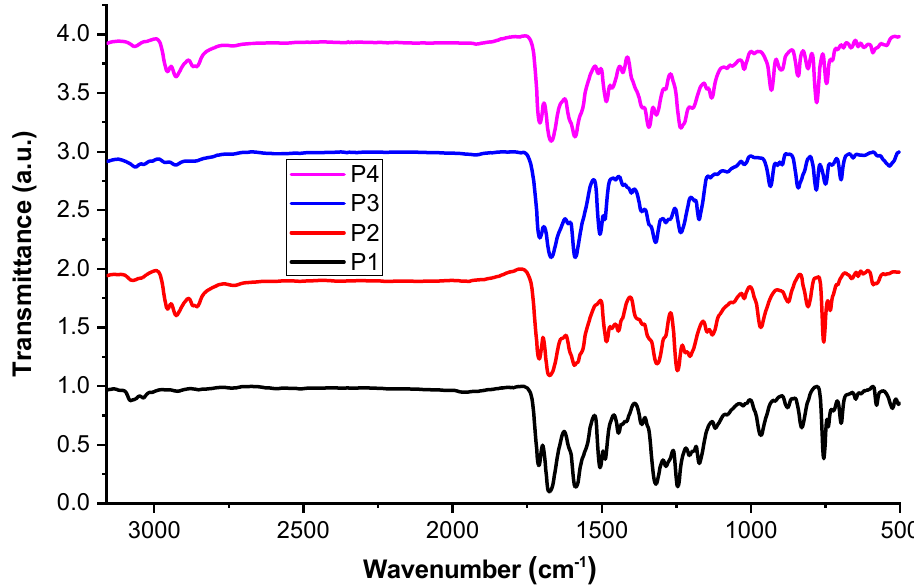
Figure 1. FT-IR spectra of polymers P1 – P4 containing naphthyl(di)imide units.